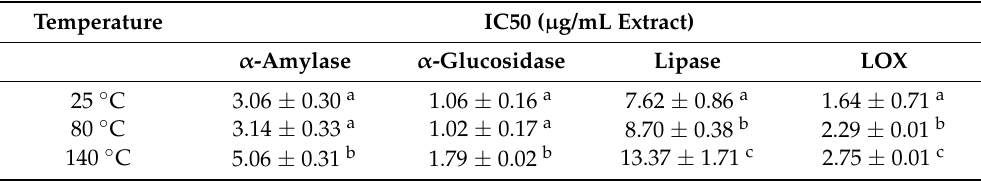
Table 8. The inhibitory capacity (IC50 values; µ g/mL) of the red grape skin extract on α -amylase, α -glucosidase, lipase, and lipoxygenase (LOX) activity thermally treated at 80 ◦ C and 140 ◦ C.